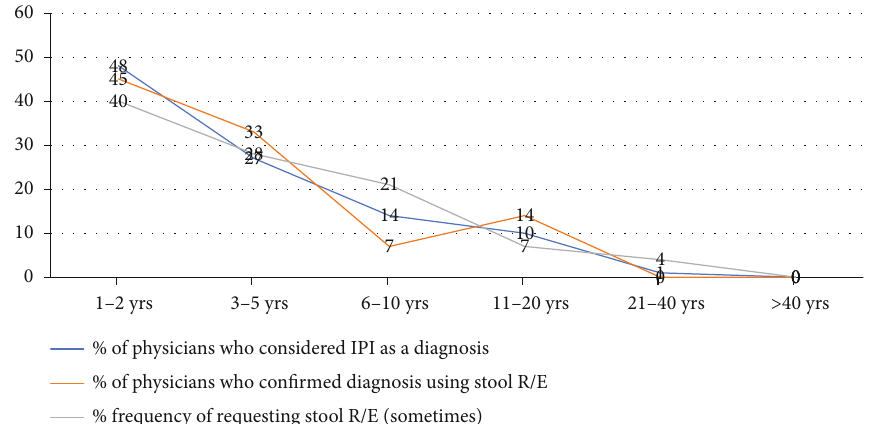
Figure 2: Relationship of the duration of years of practice distribution with consideration of IPI as a diagnosis, con fi rmation with stool R/E, and frequency of request of stool